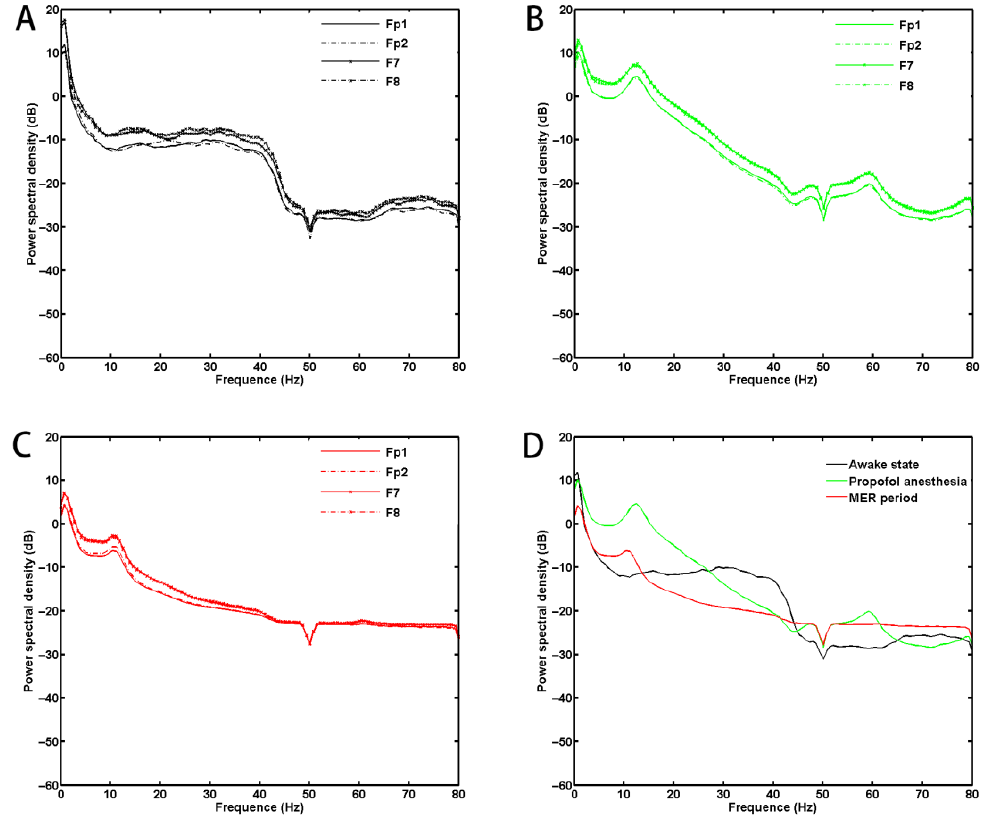
Figure 4. Power spectral density data of one patient in three states. Power spectral density of the four channels of one patient in awake states ( A ), propofol anesthesia state ( B ), and shallow anesthesia during MER ( C ). ( D ) shows power spectral density data of three states of a channel (Fp1).